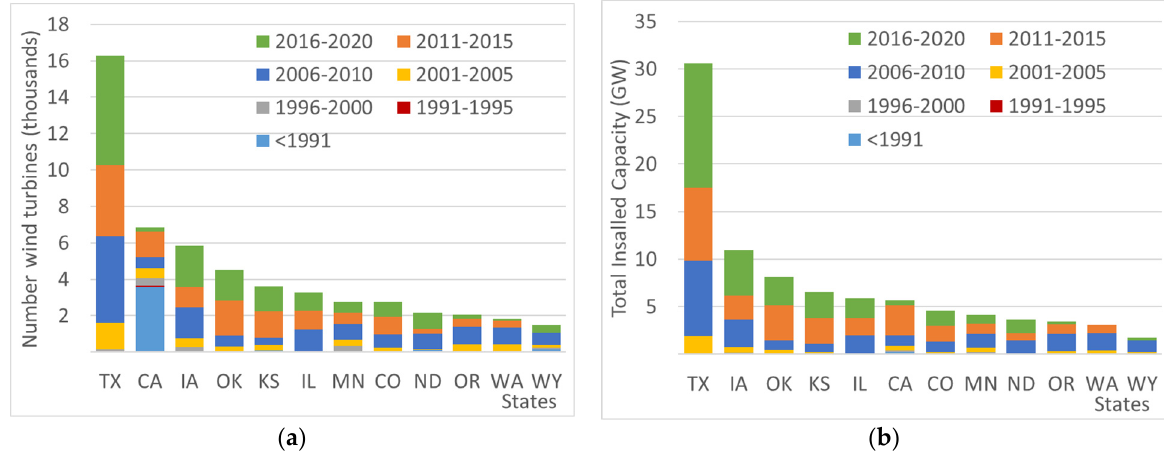
Figure 4. Wind turbines in 12 states that contain more than 80% of installed wind capacity in the U.S. ( a ) Number of wind turbines, including 2058 wind turbines with no NPC data in California. ( b ) Total installed capacity (GW).